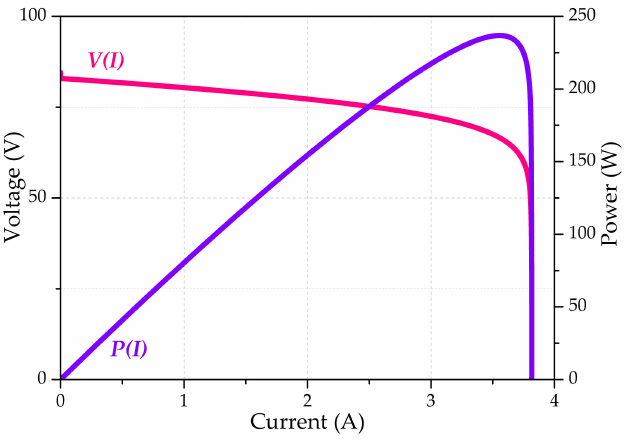
Figure 5. Characteristic curve of PV cells at standard conditions (reprinted from Ref.